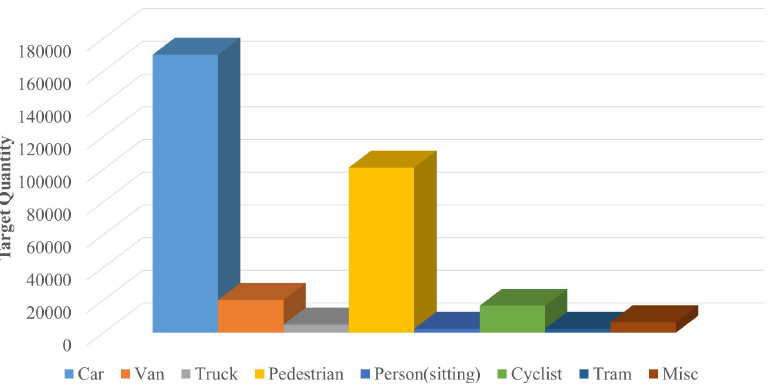
Figure 10. KITTI dataset data distribution.